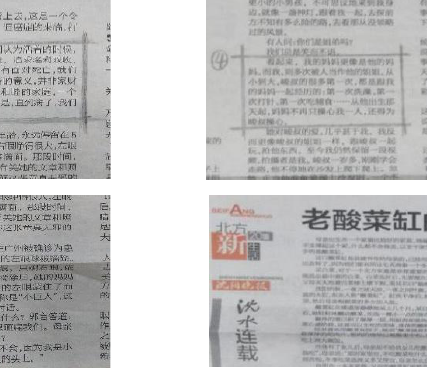
Figure 1. Reading materials.